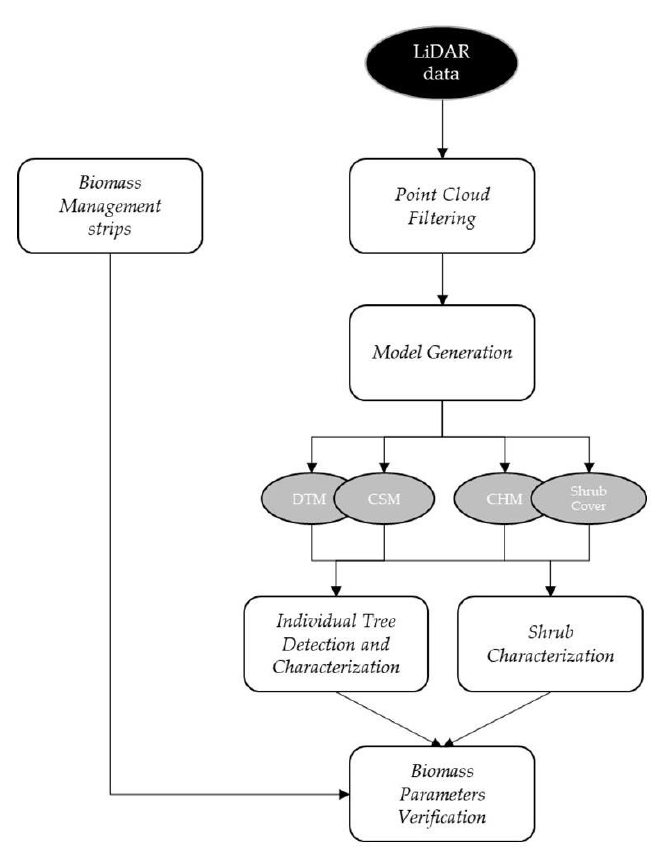
Figure 3. Process flow diagram of the applied methodology. DTM: Digital Terrain Model, CSM: Canopy Surface Model, CHM: Canopy Height Model.